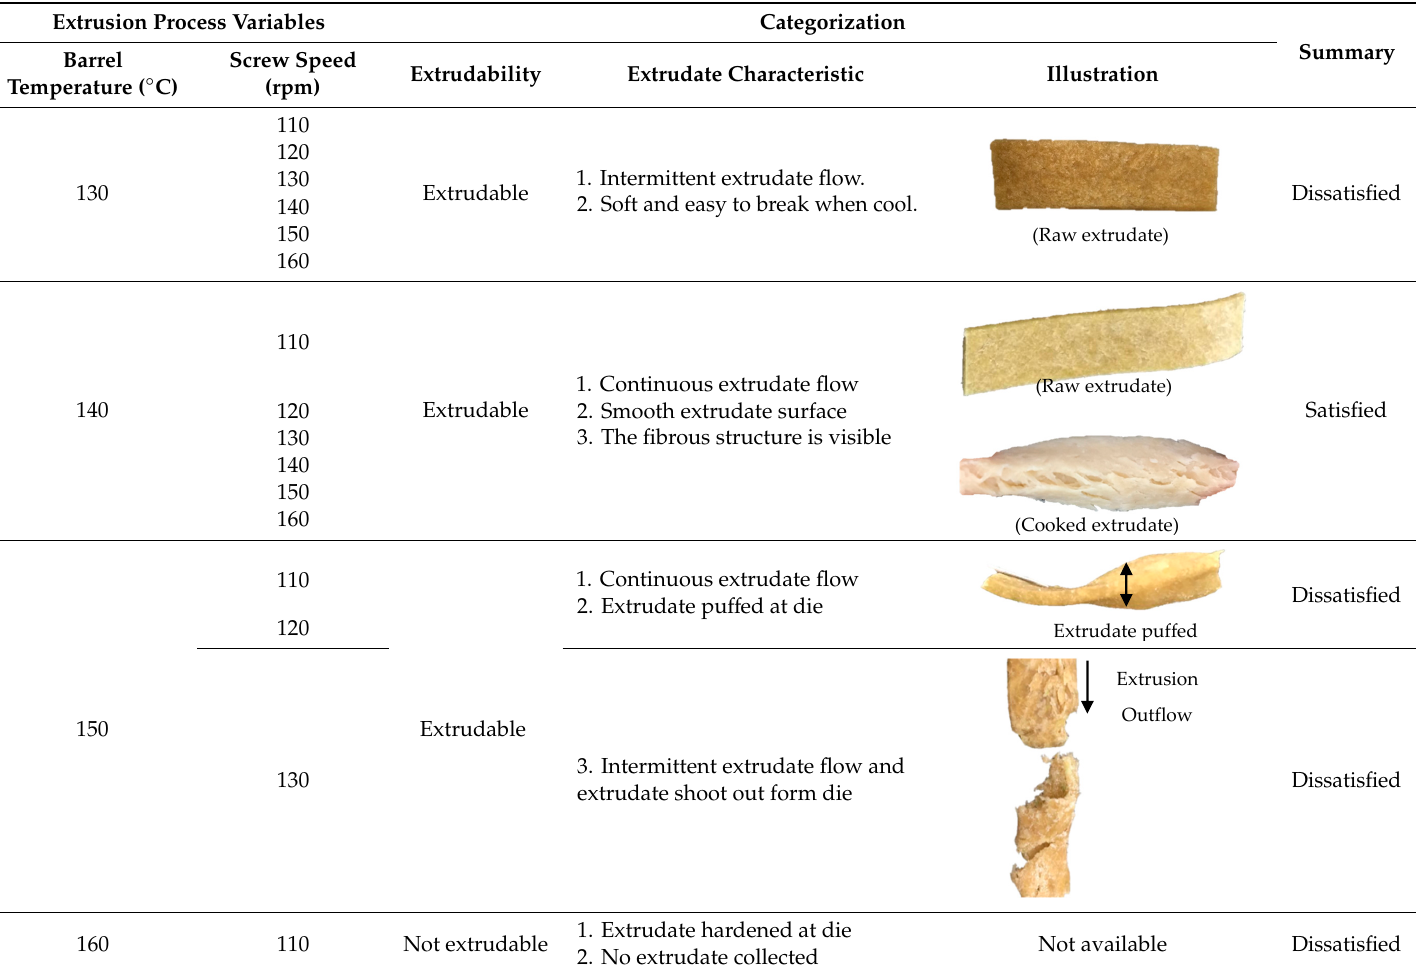
Table 2. Extrudability and extrudates’ satisfactory characteristics at different barrel temperatures, screw speeds, and oyster mushroom contents.